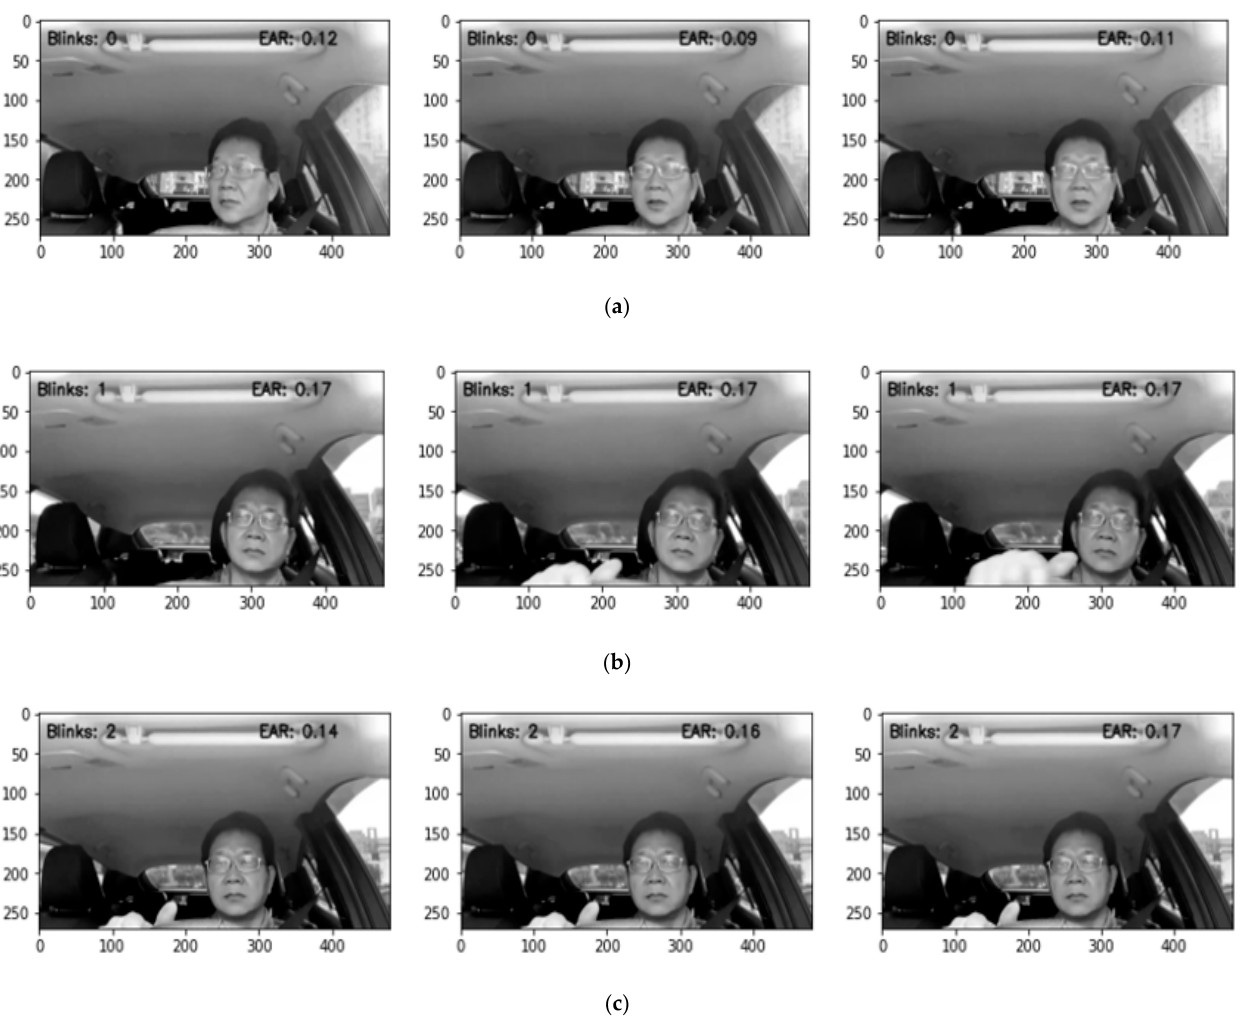
Figure 8. Video 2 Eye Blink Prediction result frame by frame (Threshold = 0.18). ( a ) The 1st blink started at the 69th frame, the middle of the action was in the 71st frame, and it ended in the 72nd frame. ( b ) The 2nd blink started at the 227th frame, the middle of the action was in the 230th frame, and it ended in the frame. ( c ) The 3rd blink started at the 272tnd frame, the middle of the action was in the 273rd frame, and it ended in the 274th frame.